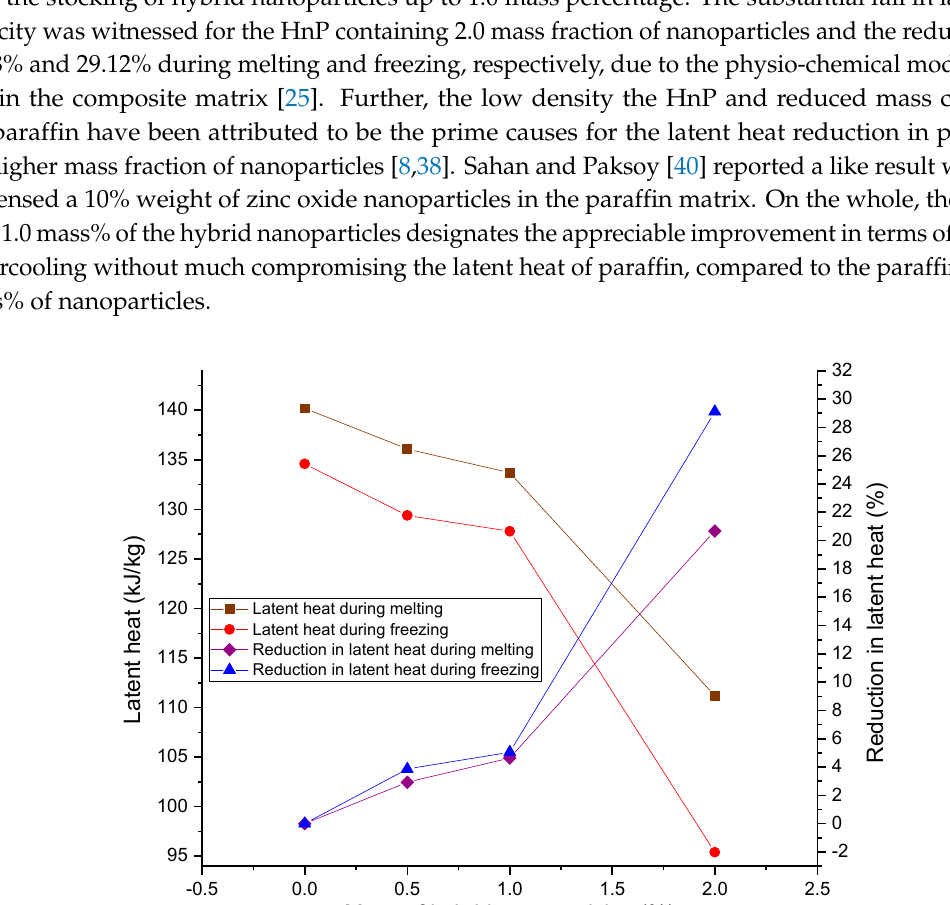
hybrid-nano / para ffi n. hybrid-nano/paraffin.